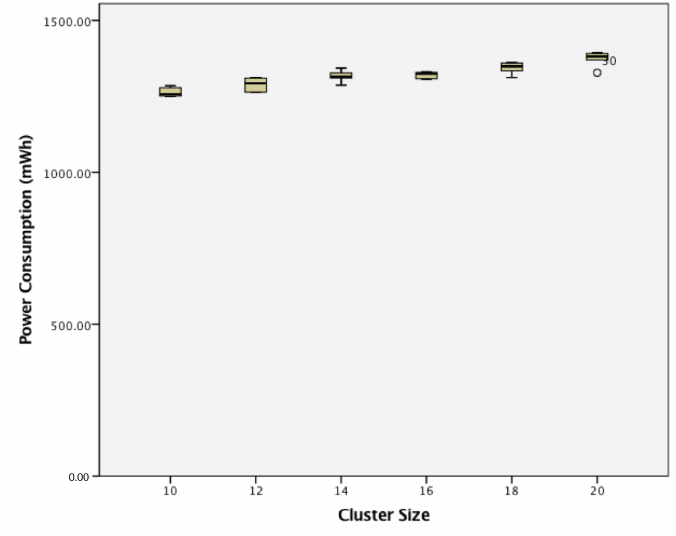
Figure 23. Power consumption of dynamic wireless sensor